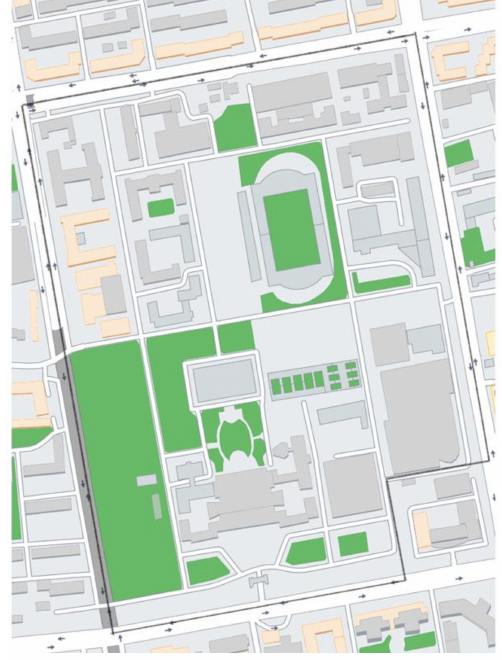
Figure 9. Plan view of the campus. Table 10. Basic information of the buildings on the investigated